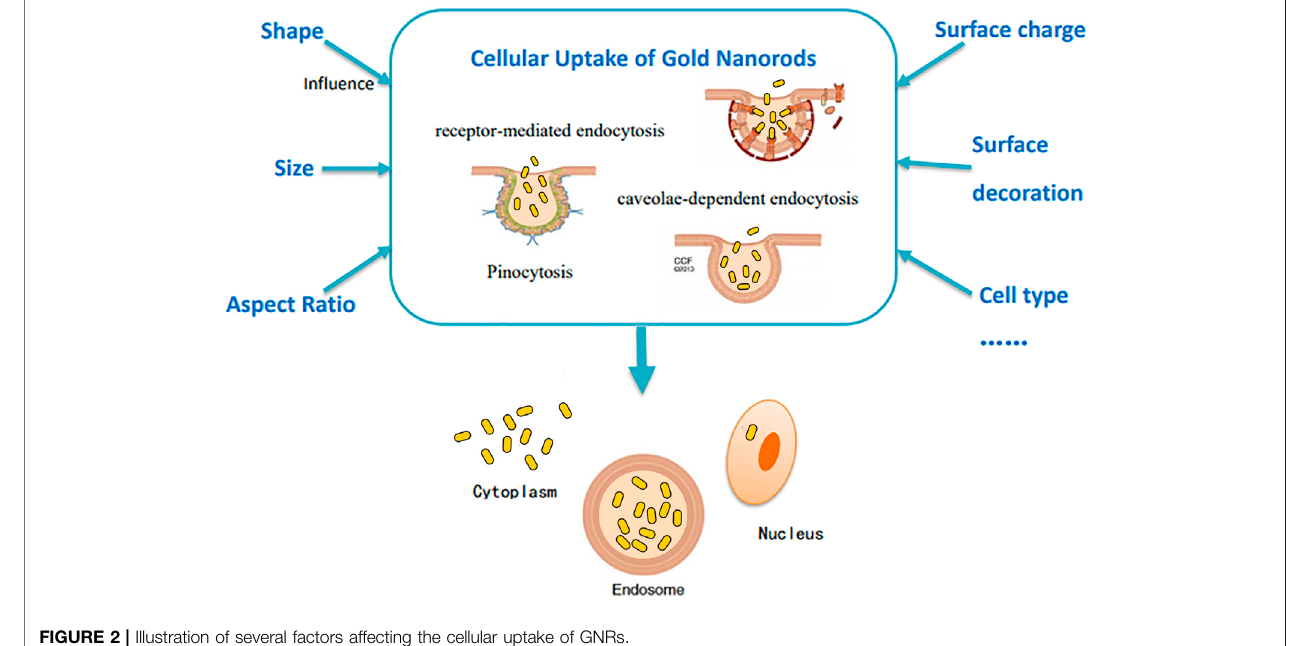
FIGURE 2 | Illustration of several factors affecting the cellular uptake of GNRs.